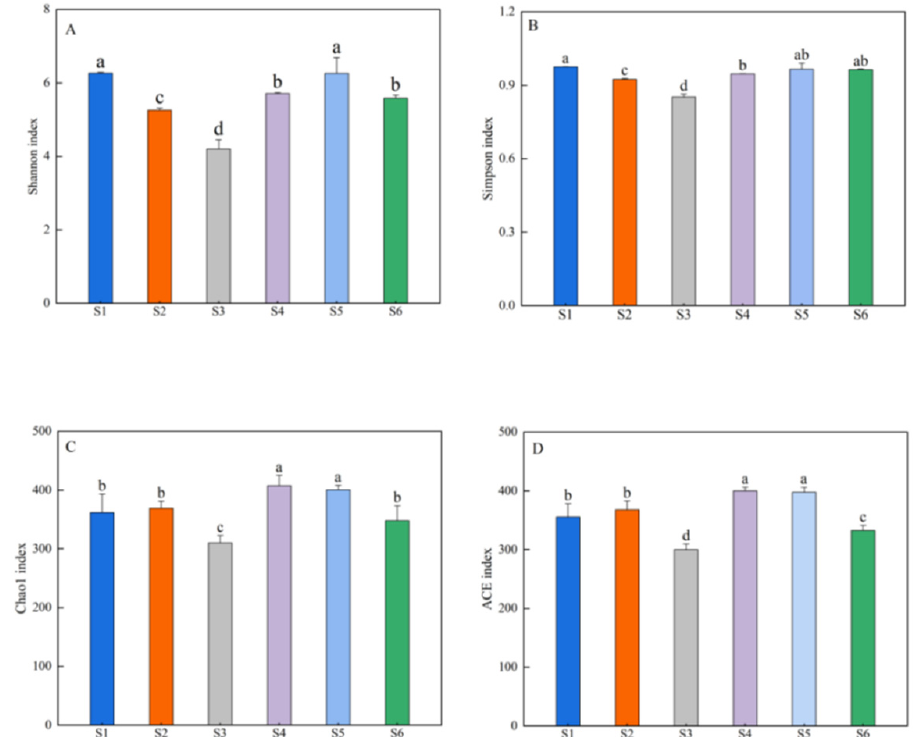
Figure 7. Diversity index of cyanobacteria communities in paddy soil in different regions. NOTE: ( A ) Shannon index; ( B ) Simpson index; ( C ) Chao1 index; ( D ) ACE index. Different letters indicate significant differences at p < 0.05.